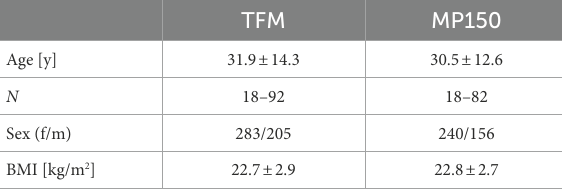
TABLE 1 Sample characteristics separated by recording